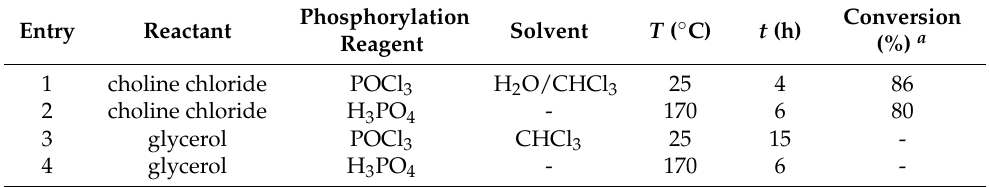
Table 1. Optimized reaction conditions and conversions of first reaction step in a batch reactor.